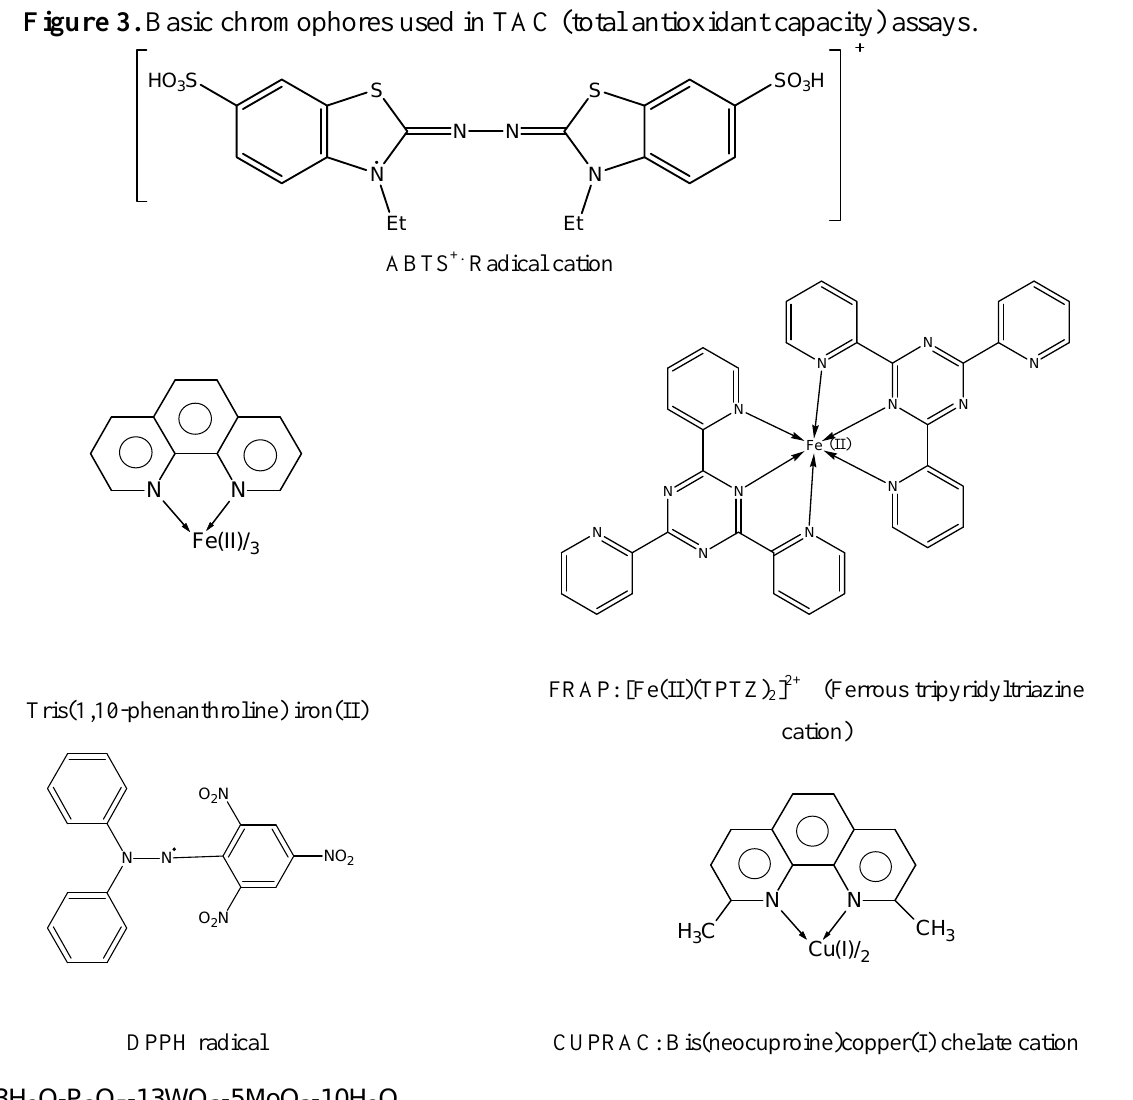
Folin: molybdophosphotungstate heteropolyanion reagent, in which Mo(VI) is reduced to Mo(V) with an e - donated by an antioxidant